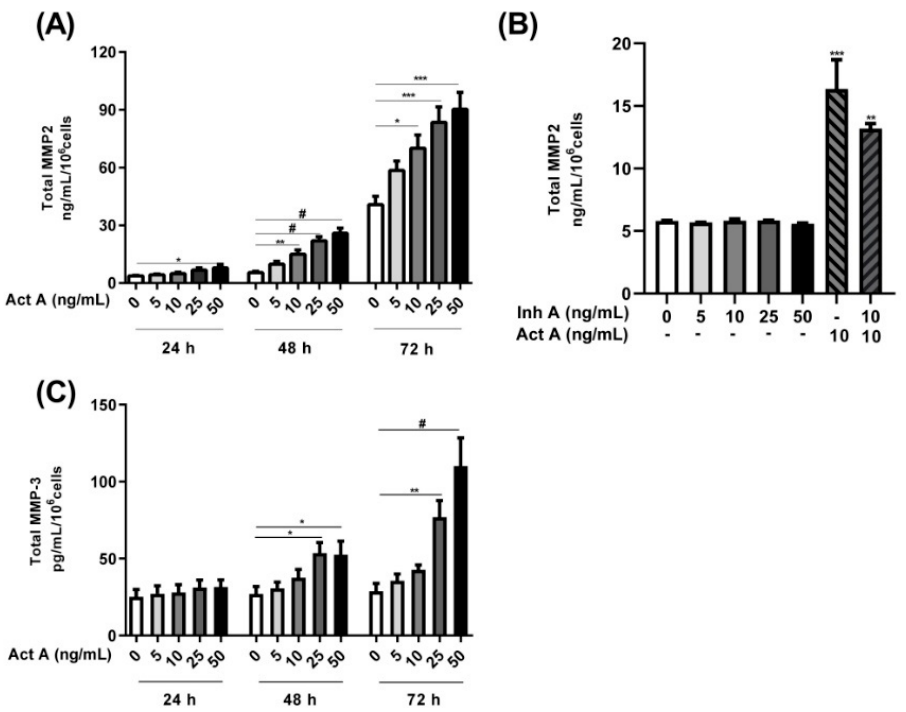
Figure 6. Time and concentration-dependent effects of activin A and inhibin A treatment on MMP2/3 secretion. Endometriotic 12Z cells were stimulated with increasing concentrations of activin A (5–50 ng/mL) for 24, 48, and 72 h and supernatants were analyzed by MMP2 ( A , B ) and MMP3 ( C ) ELISAs. Cells were also treated with inhibin A, with (10 ng/mL) or without activin A for 48 h and supernatants were analyzed by MMP2 ELISAs ( B ). Activin A treatment significantly augmented MMP2 and MMP3 secretion in a time- and concentration-dependent manner ( A , C ). Inhibin A treatment of the cells had no effect on MMP2 secretion although the simultaneous addition of inhibin A and activin A resulted in a moderate reduction in the activin A-mediated increase in MMP2 secretion ( B ). Untreated cells were used as controls. Each bar represents the mean ± SEM of 3 independent experiments performed in duplicate. Dunnett’s test was used for statistical analysis; * p ≤ 0.05; ** p < 0.01; *** p < 0.001; # p < 0.0001; Act A, activin A; Inh A, inhibin A.